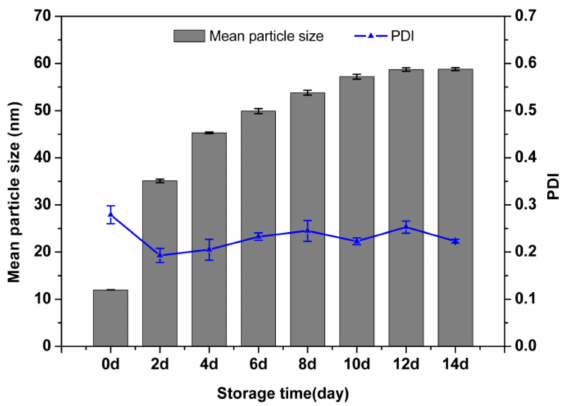
Figure 7. The mean particle size and PDI of the nanosuspension at 54 ◦ C storage condition.